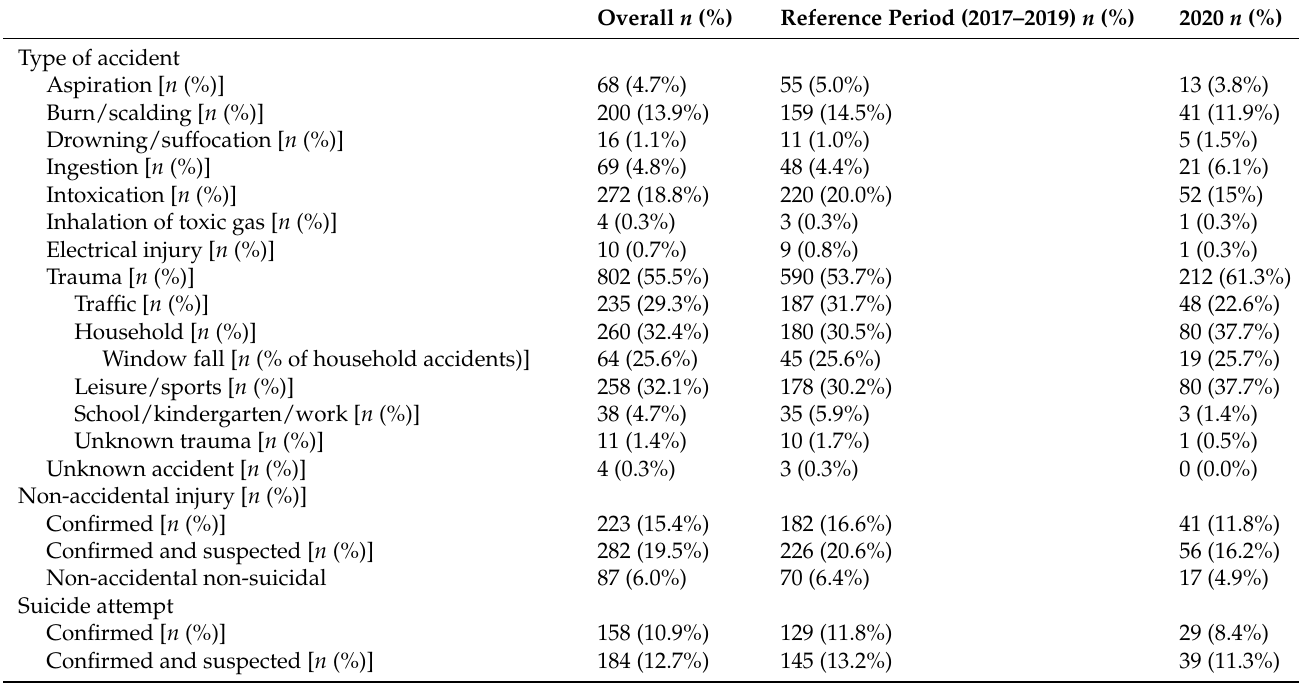
Table 2. Types of